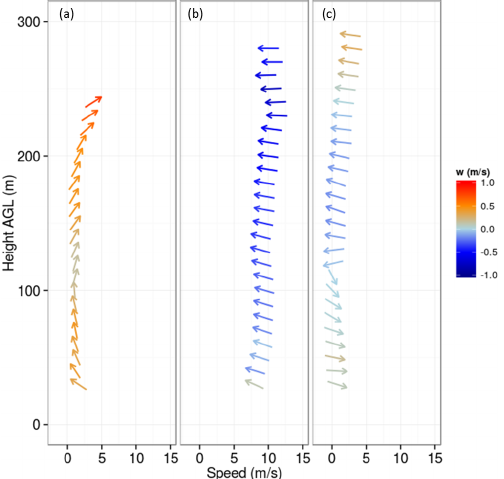
Figure 12. Vertical profiles measured at ST2 during (a) transition to downvalley flow (16 August 2011, 20:00 LT) and (b) synoptically driven downvalley flow (17 August 2011, 10:30 LT), and (c) transi- tion to upvalley flow (18 August 2011, 09:30